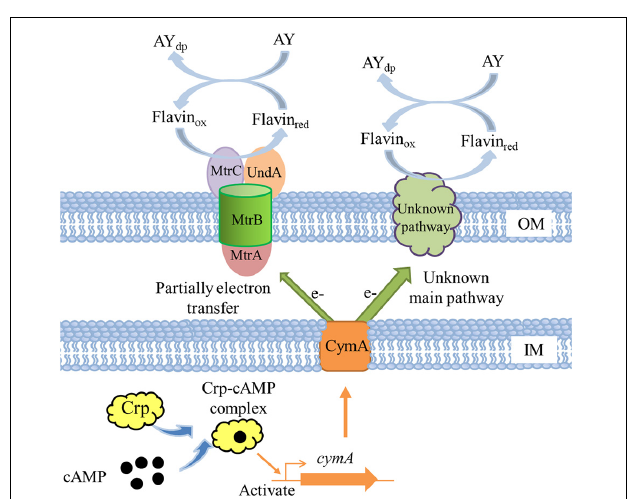
FIGURE 8 | A proposed molecular model of Crp regulating AY decolorization in S. putrefaciens CN32. OM indicates outer membrane; IM indicates inner membrane; AY dp indicates degradation products of acid